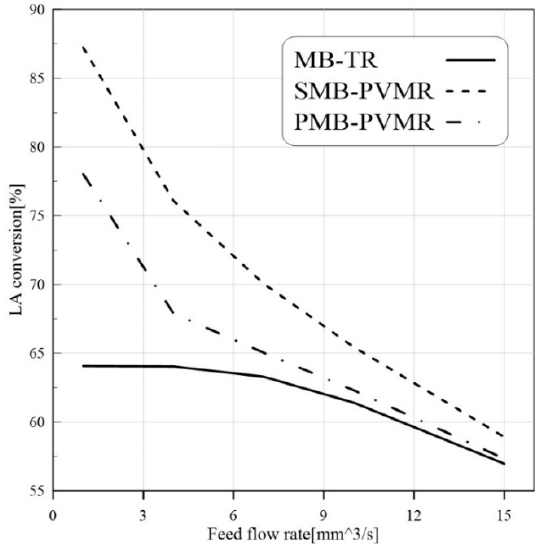
Figure 5. Comparison of LA conversion in MB-TR, PMB-PVMR, and SMB-PVMR based on variations in the feed flow rate. Et/LA:1, temperature: 333 K, and W = 8.6 g.